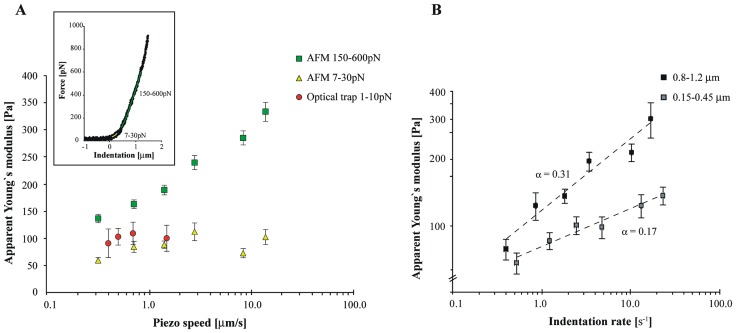
Cell stiffness at low and high indentation force at different indentation speeds.A) Young’s modulus of cells obtained with the optical trap (red) and AFM (yellow and green). For each speed 16 to 41 cells were measured. The data is plotted as function of the piezo speed (the actual cell deformation speed will be slightly lower and depends on the ratio between the cellular spring constant and cantilever spring constant). When the AFM indentation curves are fitted at 7–30 pN (yellow triangles), the obtained Young’s moduli are independent of the indentation speed. When the indentation curves are fitted at 150–600 pN (green squares) the apparent moduli increase a multifold at higher indentation speeds. Inset) AFM indentation curves were fitted between 7–30 pN (yellow) and 150–600 pN (green) using the Hertz model (Eq. 1). B) To compare the viscous contribution at the different indentation rates at an identical indentation of around 1 µm, we plotted the apparent modulus k as function of the indentation rate f of the experiment. This rate is defined as f = 1/(2*(t
1.2-t
0.8)), where t
1.2-t
0.8 is the time it took for the indentation to increase from 0.8 to 1.2 µm. The plot on a double logarithmic scale shows the fit to k(f) = A*f α, where α = 0.31 (and A = 118). Similarly, we plotted the apparent modulus at an indentation of around 0.3 µm. The data still follows a power law, but with a reduced exponent of α = 0.17 (A = 80).